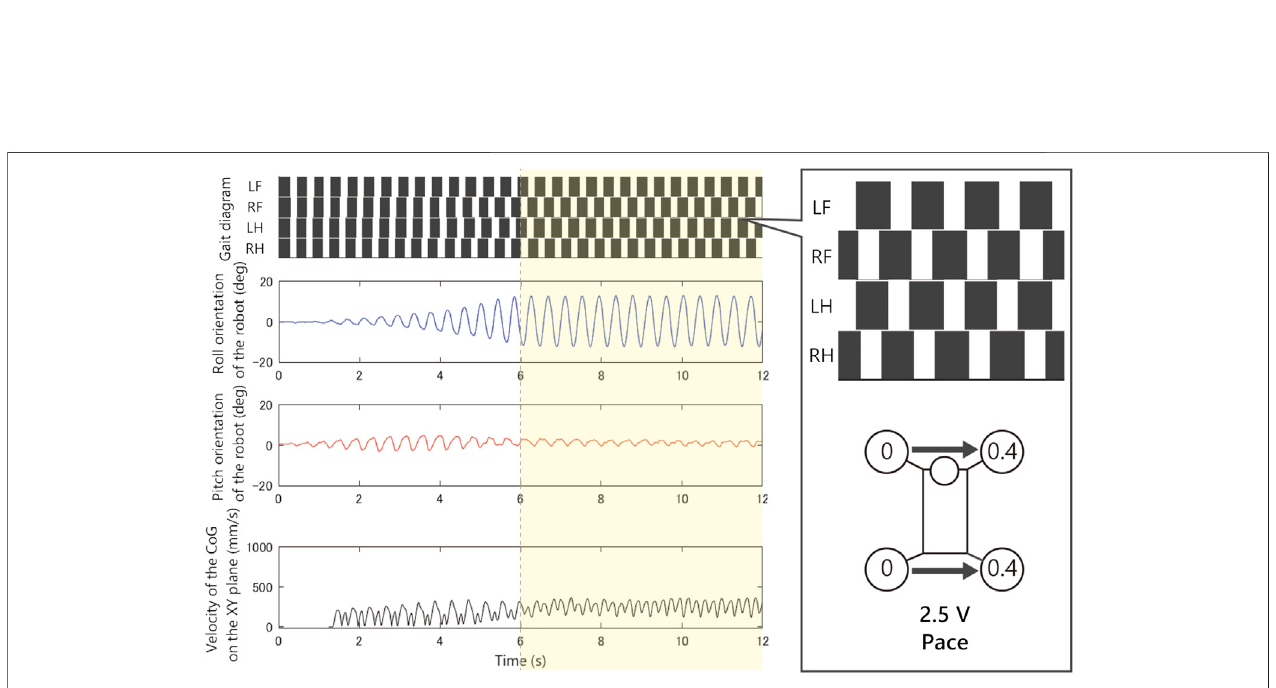
FIGURE 10 | Experimental result with an input voltage of 2.5 V. From the top: gait of the quadruped robot, roll, and pitch orientation. All the trials from the initial values converged to this pace gait.